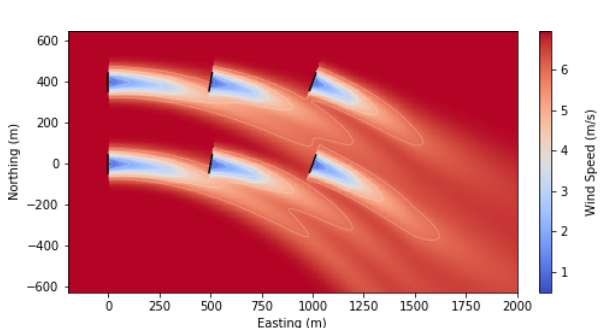
Figure 9. A second visualization of a flow field with more complex heterogeneous wind direction. Wind input measurements are indi- cated using diamond markers, and turbine rotors are shown with black